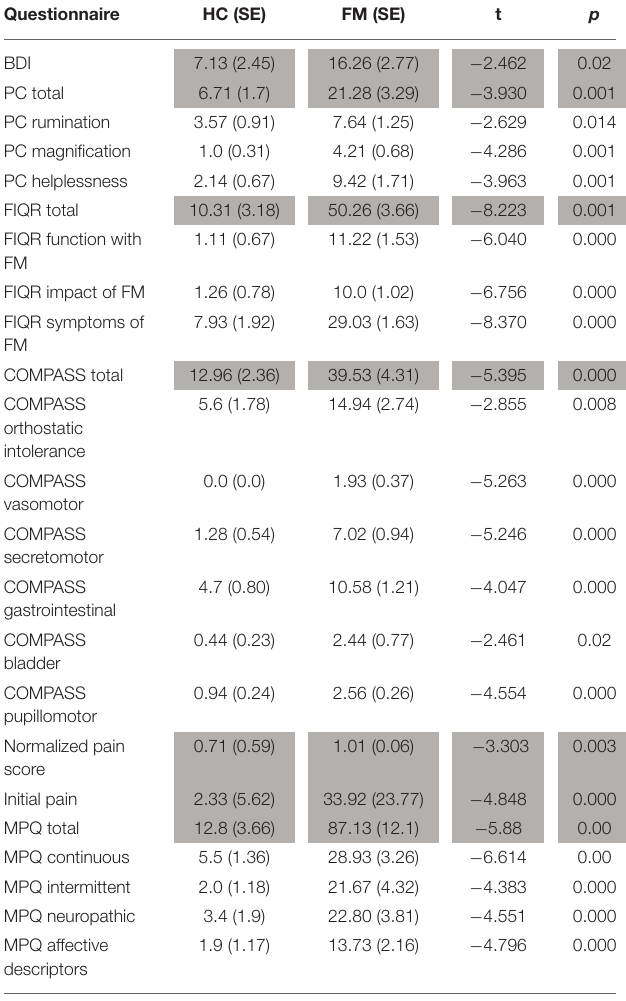
Shaded cells represent overall questionnaire scores, while unshaded cells represent subscales of the